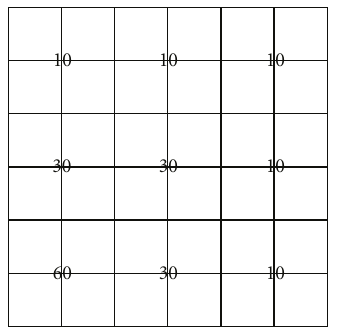
Figure 8: An example of uneven nodes’